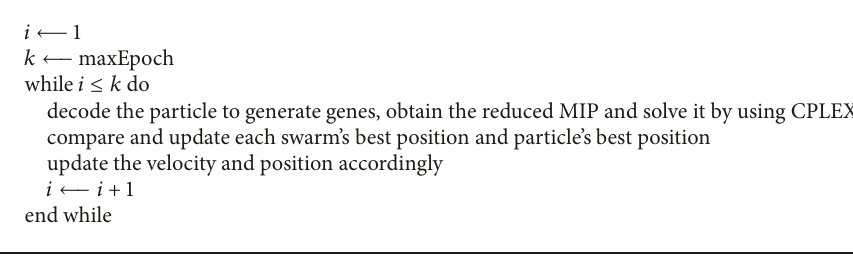
Algorithm 1: PSO algorithm main